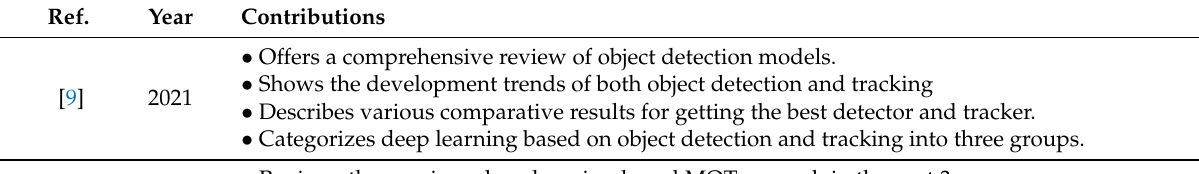
Table 1. List of contributions from previous surveys on MOT.